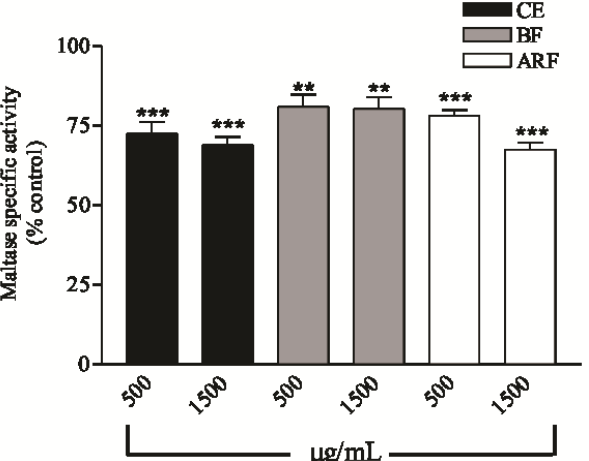
Figure 2. In vitro effect of crude extract (CE), n -butanol fraction (BF) and aqueous residual fraction (ARF) of B. articulata on specific activity of maltase, in the duodenal portion of rat intestine. Incubation = 5 min. Values are expressed as mean ± S.E.M.; n = 6 for each group. Significant at ** p < 0.001; *** p < 0.0001 compared to control